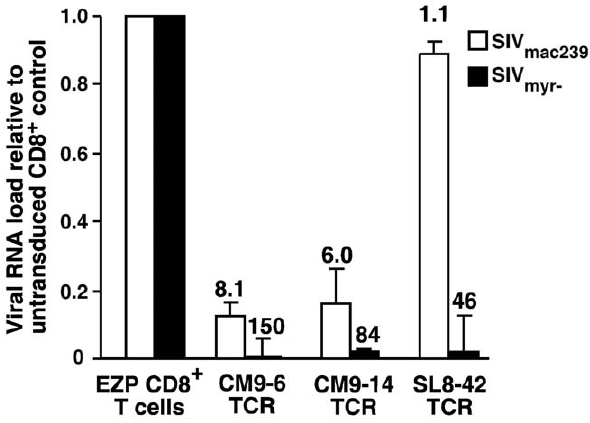
Figure 5. Suppression of viral RNA load. A graph of the viral load in the TCR-transduced T-cell mixed cultures relative to those containing untransduced CD8 + T cells is presented. The amount of viral suppression for each culture (viral load of the untransduced CD8 + cells co-culture divided by the load of anti-SIV effector cultures) is indicated above each bar. The average viral loads from duplicate independent PCR-based measurements of the untransduced CD8 + cell co-cultures were 6.6 6 10 8 copies of SIV Gag per ml, SD 8.7 6 10 6 for wild-type SIV mac239 and 3.8 6 10 8 copies of SIV Gag per ml, SD 1.7 6 10 7 for the myristylation mutant SIV myr- . Error bars represent standard deviations.